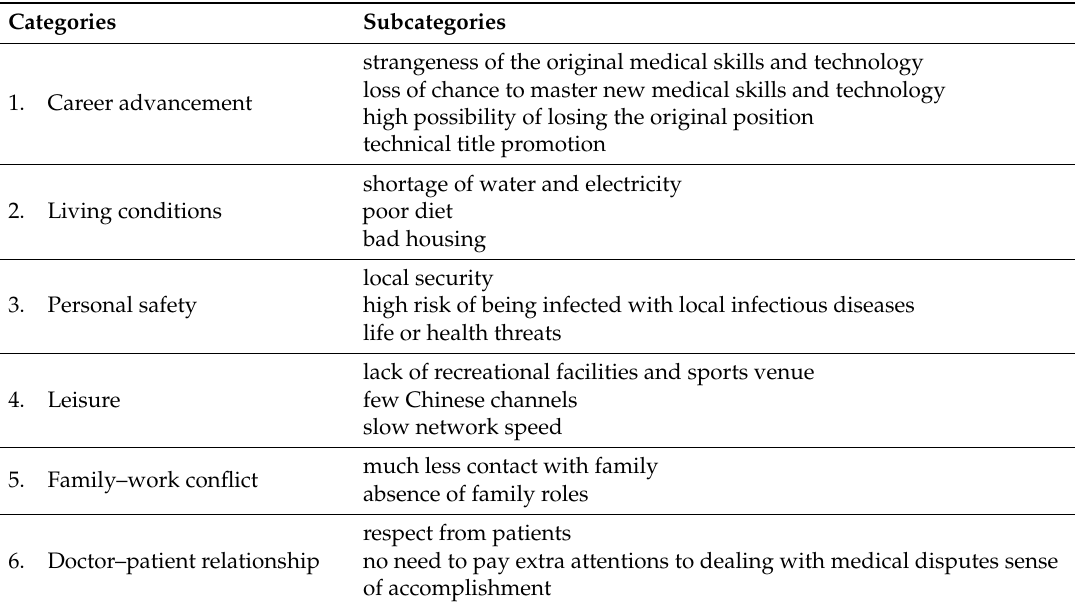
Table 2. Six influencing factors for expatriation